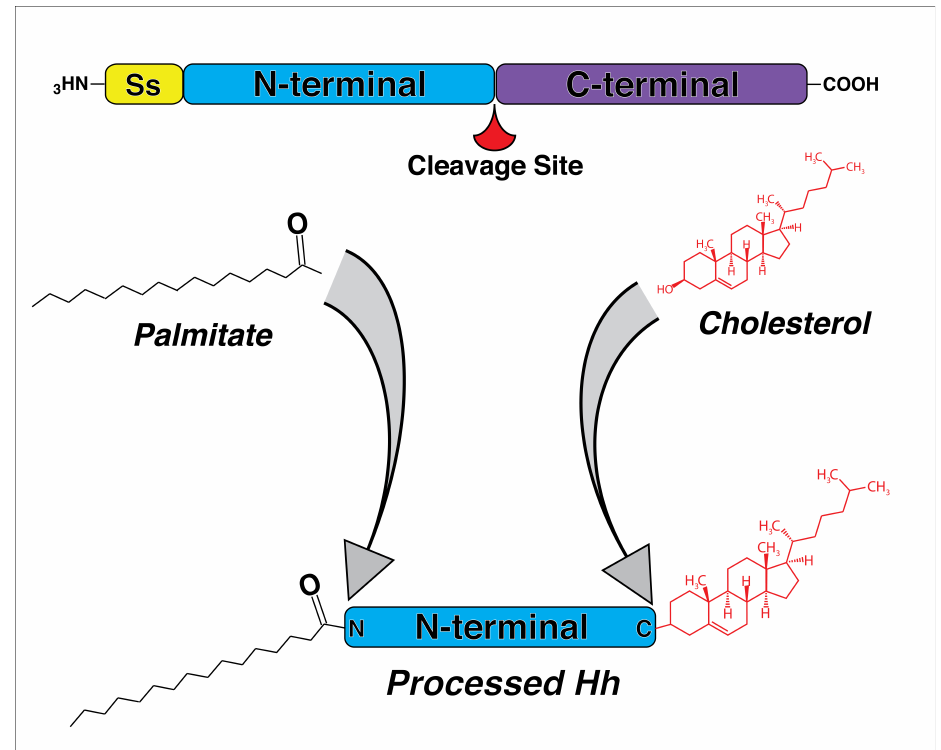
Figure 1. Biogenesis of processed Hedgehog (Hh) ligand. Hh ligand is produced as a large precursor protein that undergoes a series of post-translational modifications prior to secretion. The N-terminal signaling domain is first cleaved from the C-terminal processing domain. Subsequent to cleavage, the N-terminal has a palmitate added to its N terminus and cholesterol added to its C terminus, resulting in a biologically active, processed Hh ligand that may be transported out of the cell. Ss—Signal sequence. Adapted from reference